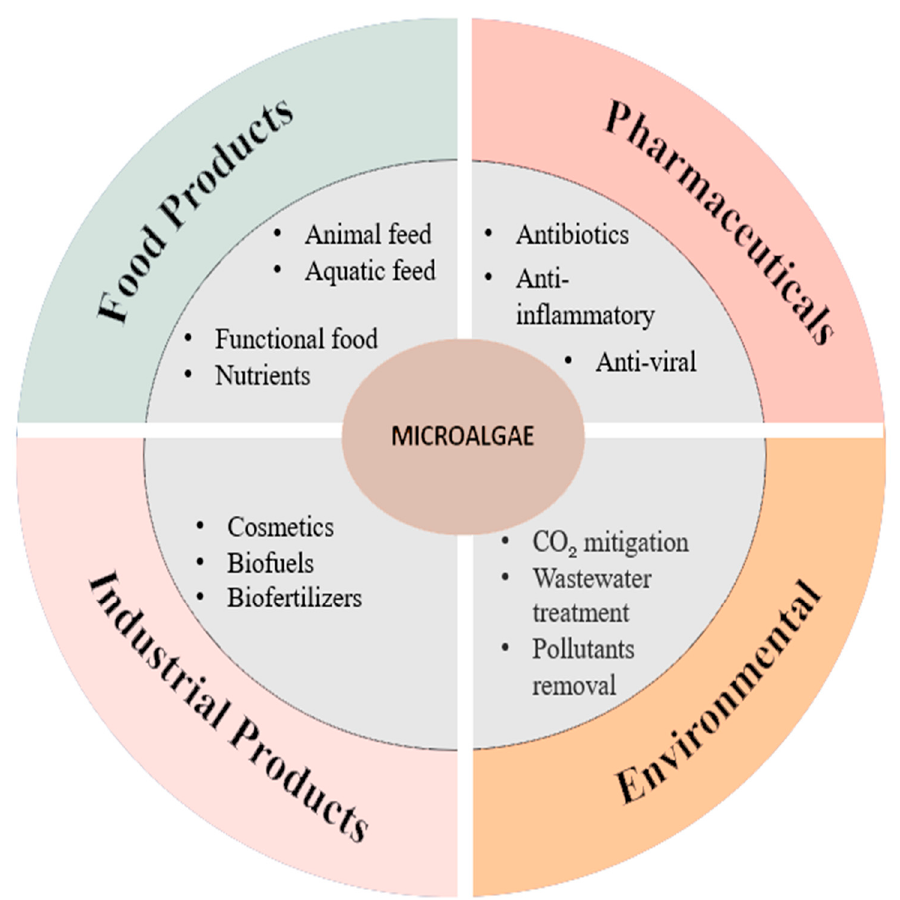
Figure 1. A display of the various applications of microalgae.